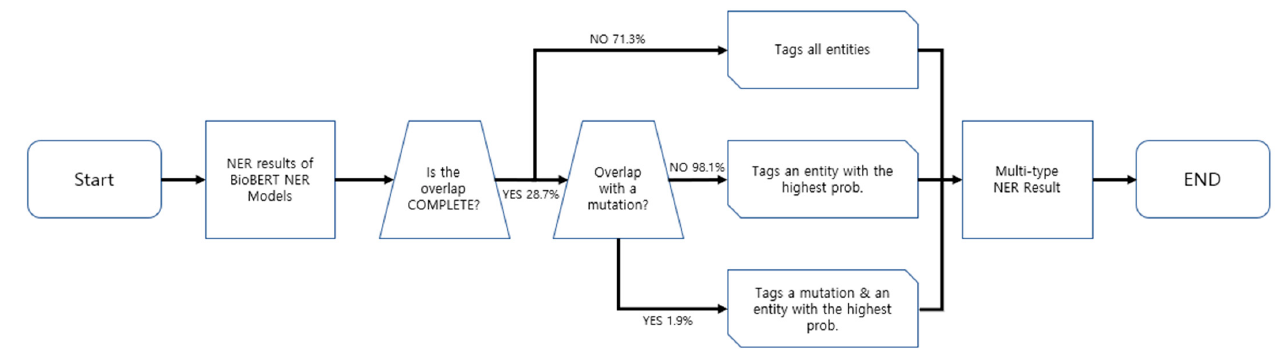
Figure 4. Schematic diagram of BERN’s decision rule.